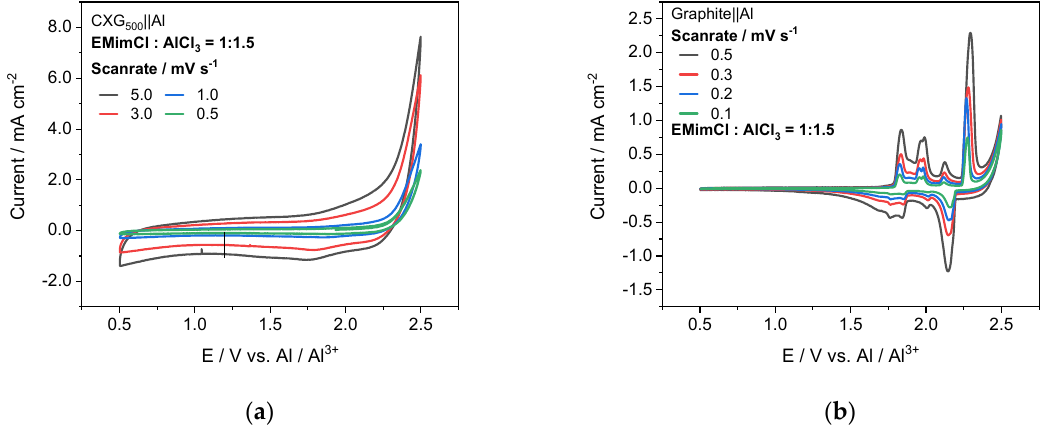
Figure A2. Scan-rate variation of cyclic voltammograms for CXG 500 ||Al ( a ) and natural graphite||Al ( b ). Table A3. Overview of results of CXG 500 ||Al experiments reported in Figure